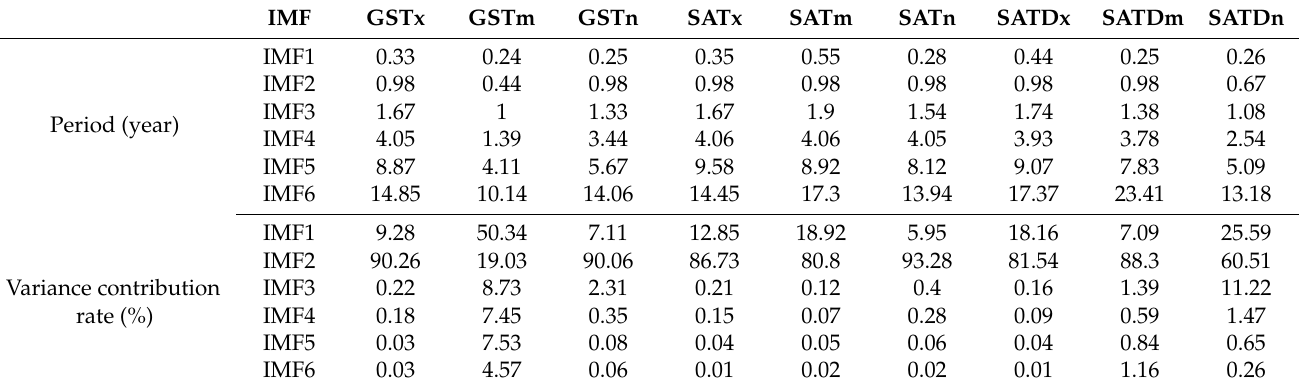
Figure 4. Decompositions of monthly averaged ( a – c ) GST-, ( d – f ) SAT-, and ( g – i ) SATD-related indexes from 1980 to 2019 into six timescales intrinsic mode function (IMF1–6) using the EEMD. Table 4. Period, variance contribution rate of monthly averaged GST-, SAT-, and SATD-related indexes from 1980 to 2019 in Southwest